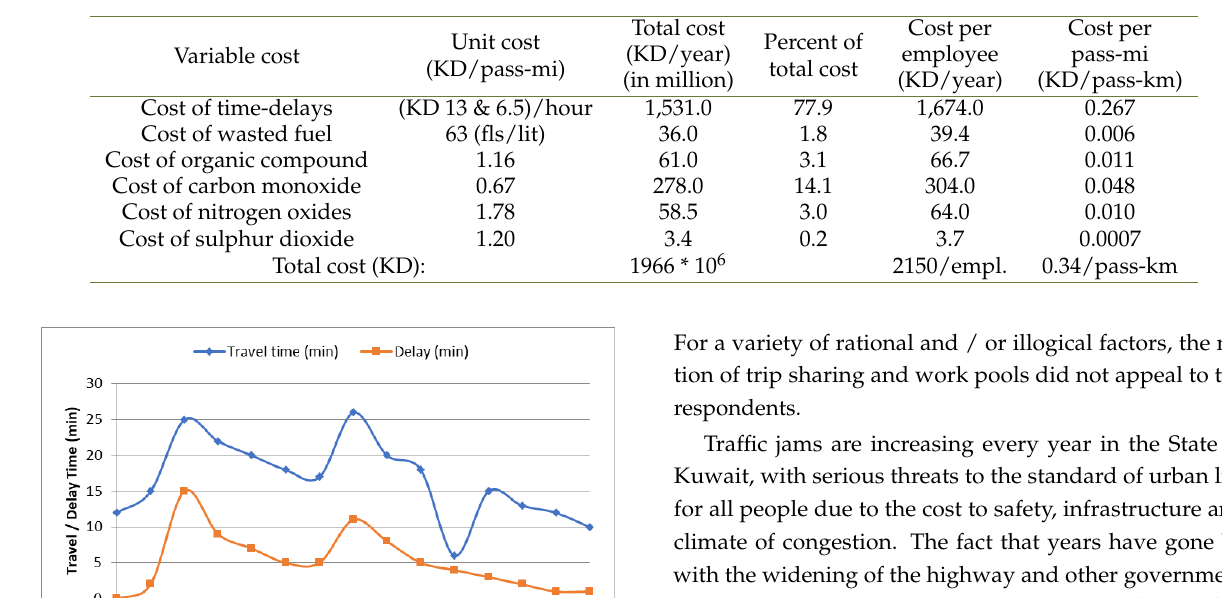
Table 1. A summary of Annual Congestion Cost Variables in Kuwait.